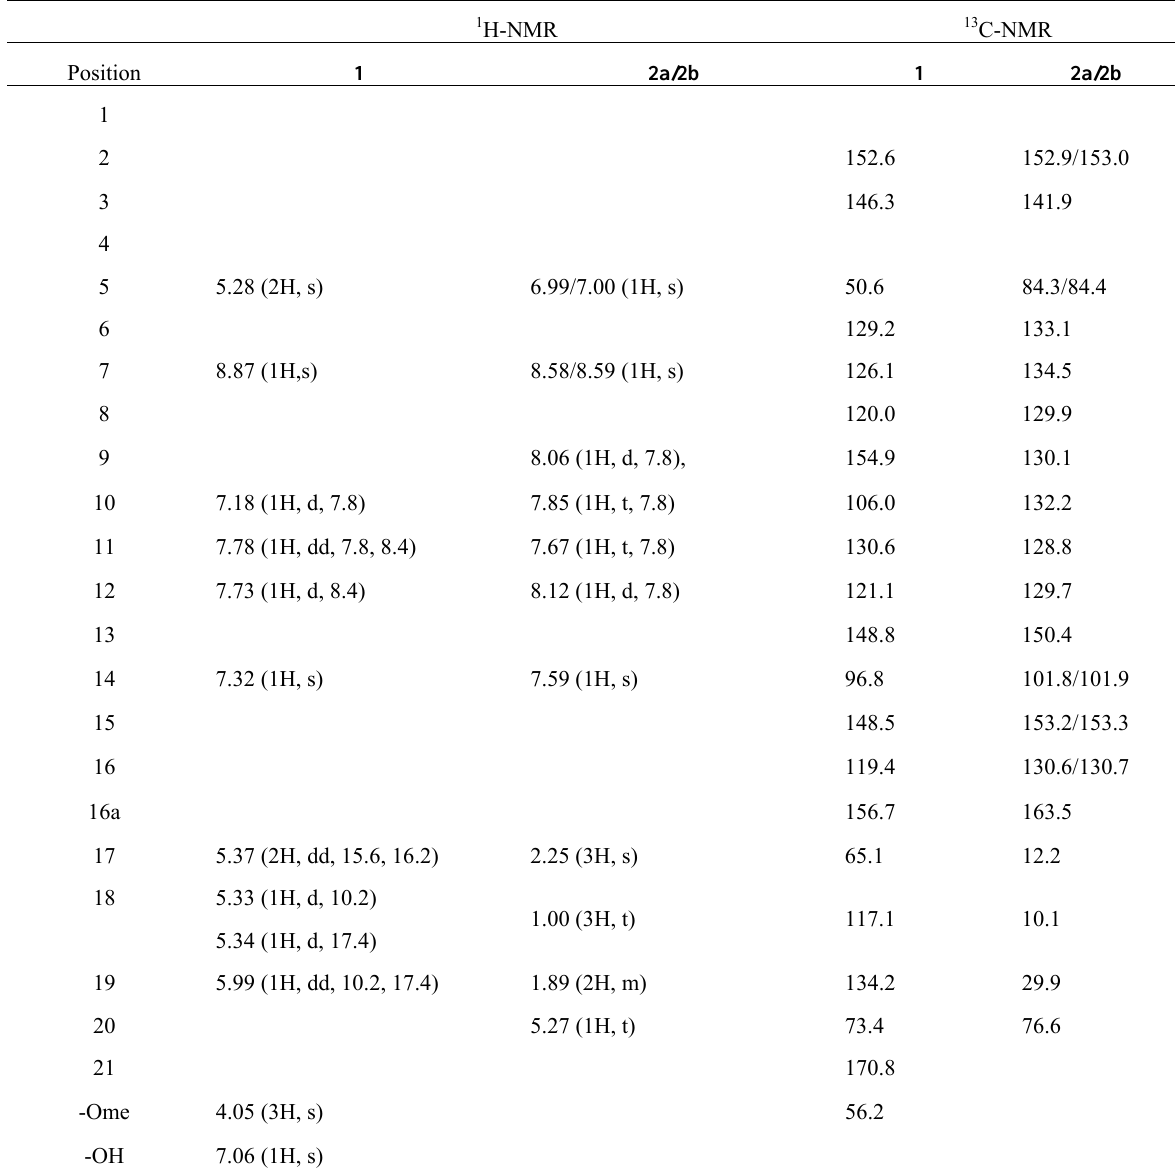
Table 1 . 1 H-NMR (600 MHz) and 13 C-NMR (125 MHz) spectral data of compounds 1 (in DMSO) and 2 (in CD OD) ( δ  in ppm, J in 3